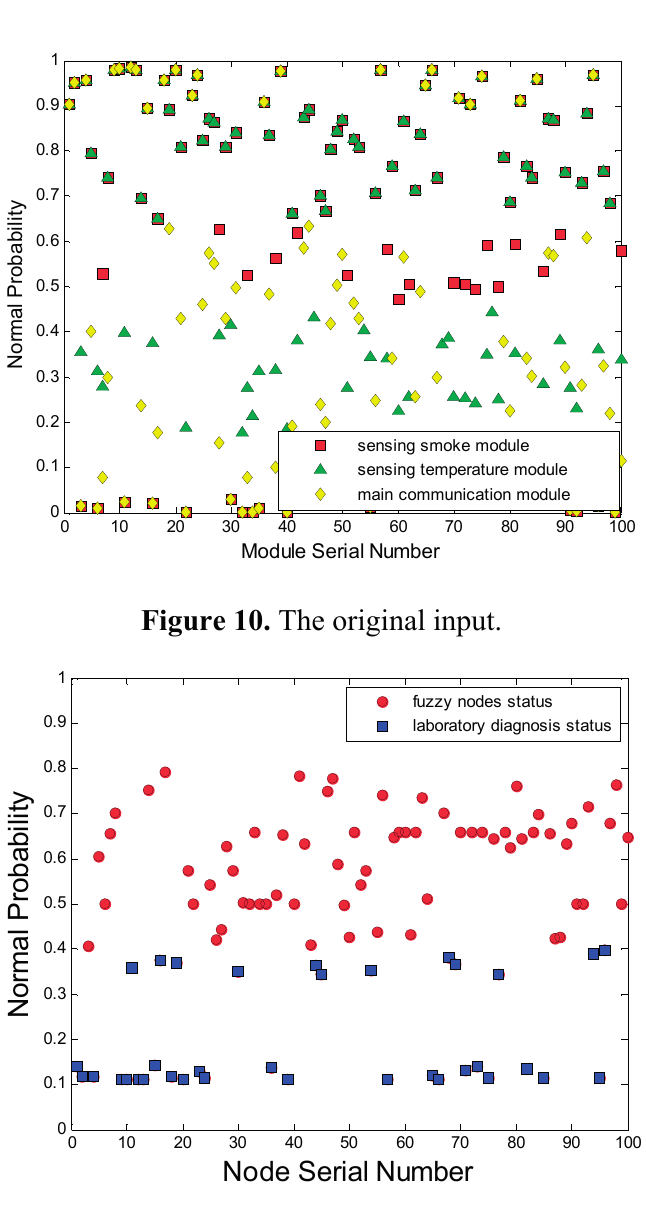
Figure 11. The actual state of all nodes and fuzzy inference